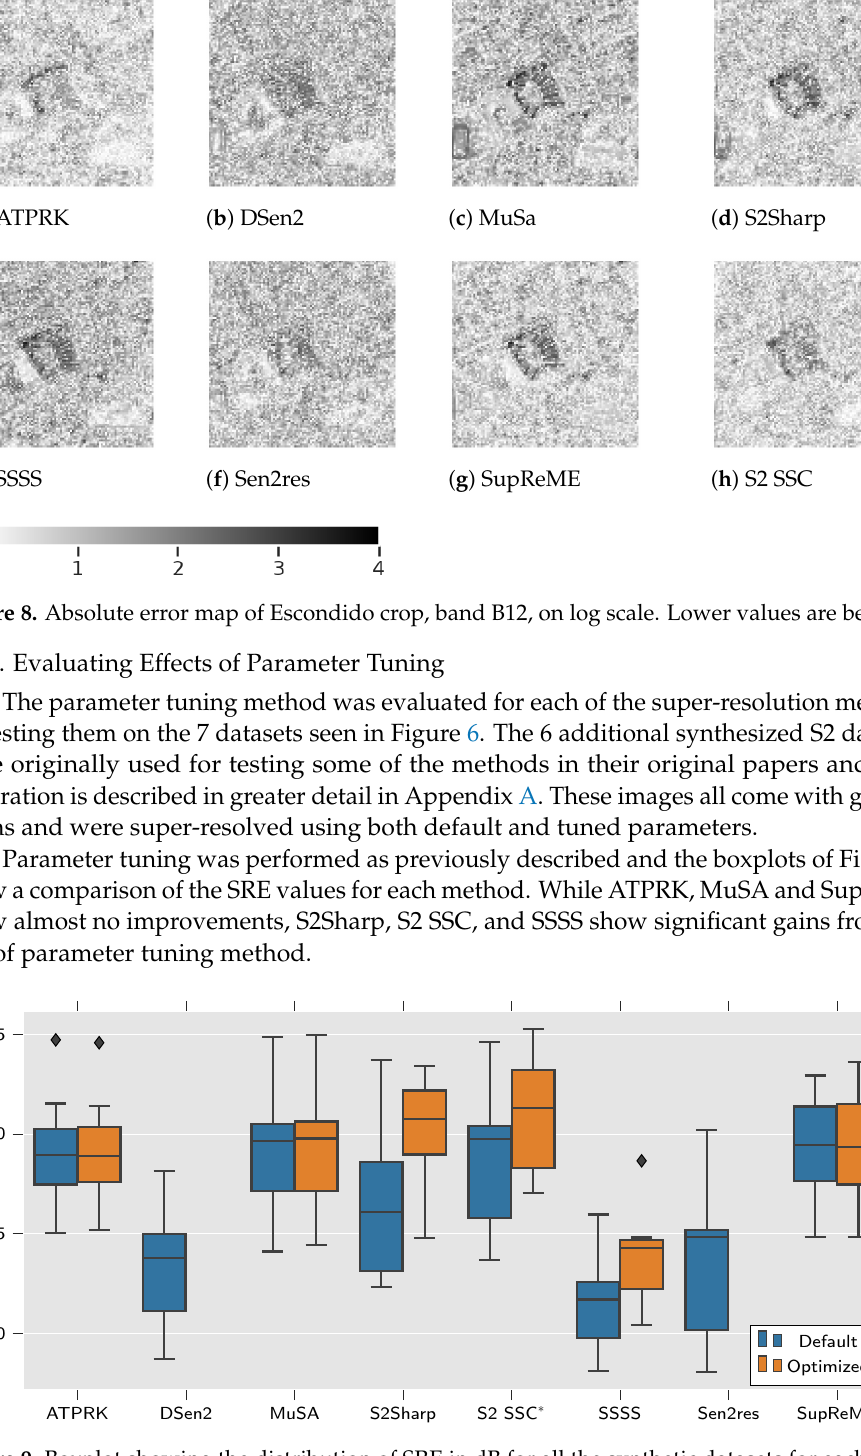
Figure 9. Boxplot showing the distribution of SRE in dB for all the synthetic datasets for each of the methods. Higher values are better. S2 SSC is only evaluted for 20 m bands but other methods include values for both 20 and 60 m